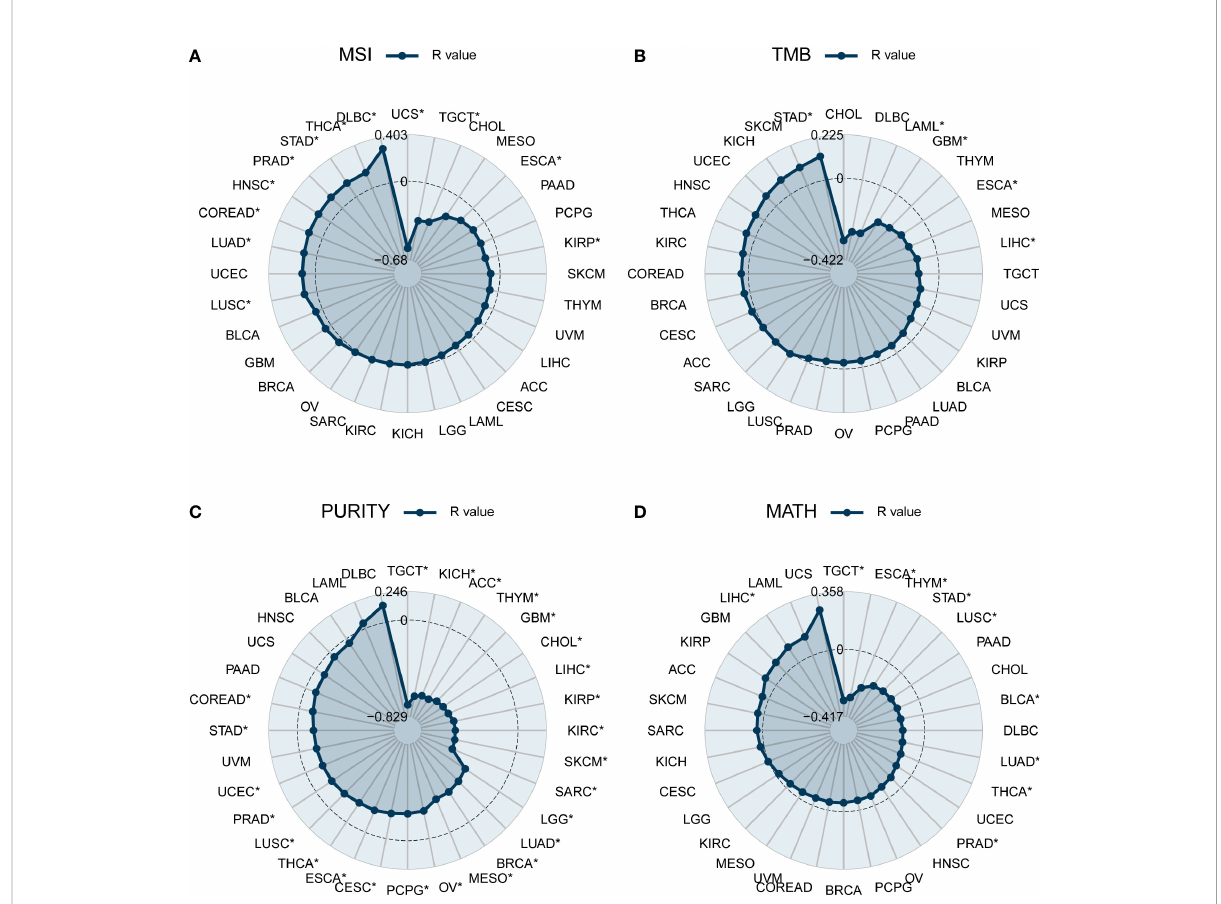
FIGURE 4 Correlation of DEF6 expression with tumor heterogeneity. Radar plot of the correlation between DEF6 expression and (A) MSI, (B) TMB, (C) tumor purity, and (D) MATH. MSI, microsatellite instability; TMB, tumor mutational burden; MATH, mutant-allele tumor heterogeneity. * p < 0.05. p -values are adjusted using the BH